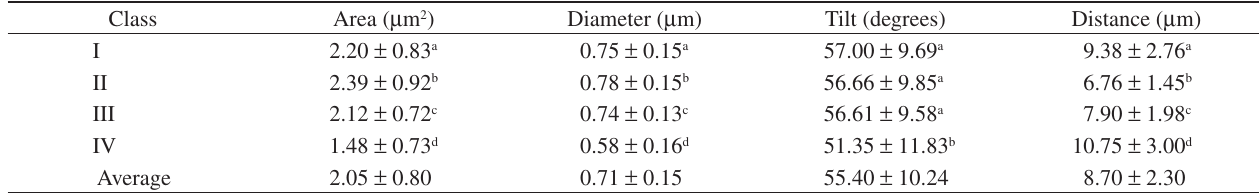
Figure 2. Classes of dentin as a function of the size, shape and distribution of the dentinary tubules. a) class I (occlusal); b) class II (pulpar dentin); c) class III (cuspidal); and d) class IV Table 4. Idem as for Table 3. Region parameters.